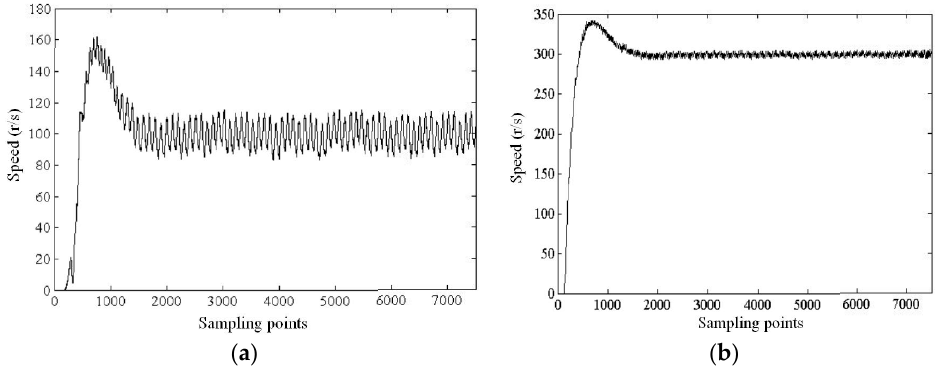
/100 =ω /100 =ω r /100 =ω r r